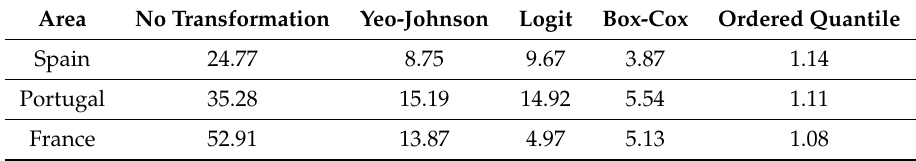
Table 2. Pearson P statistics for each area and